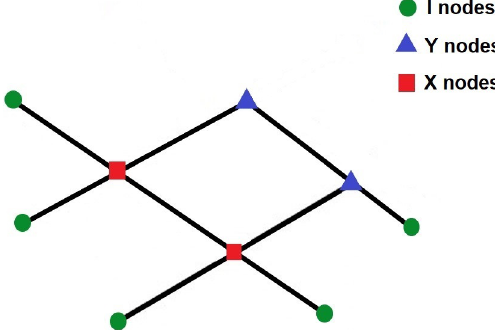
Figure 3. Schematic fracture network showing three different types of nodes.